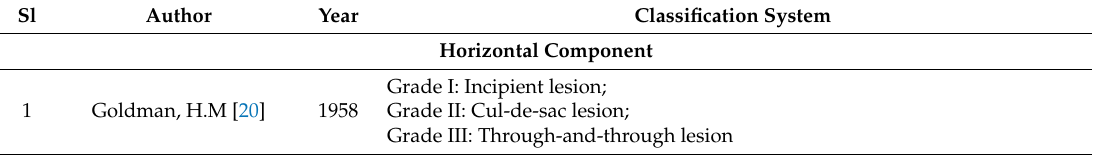
Table 1. Various proposed classification systems of furcation